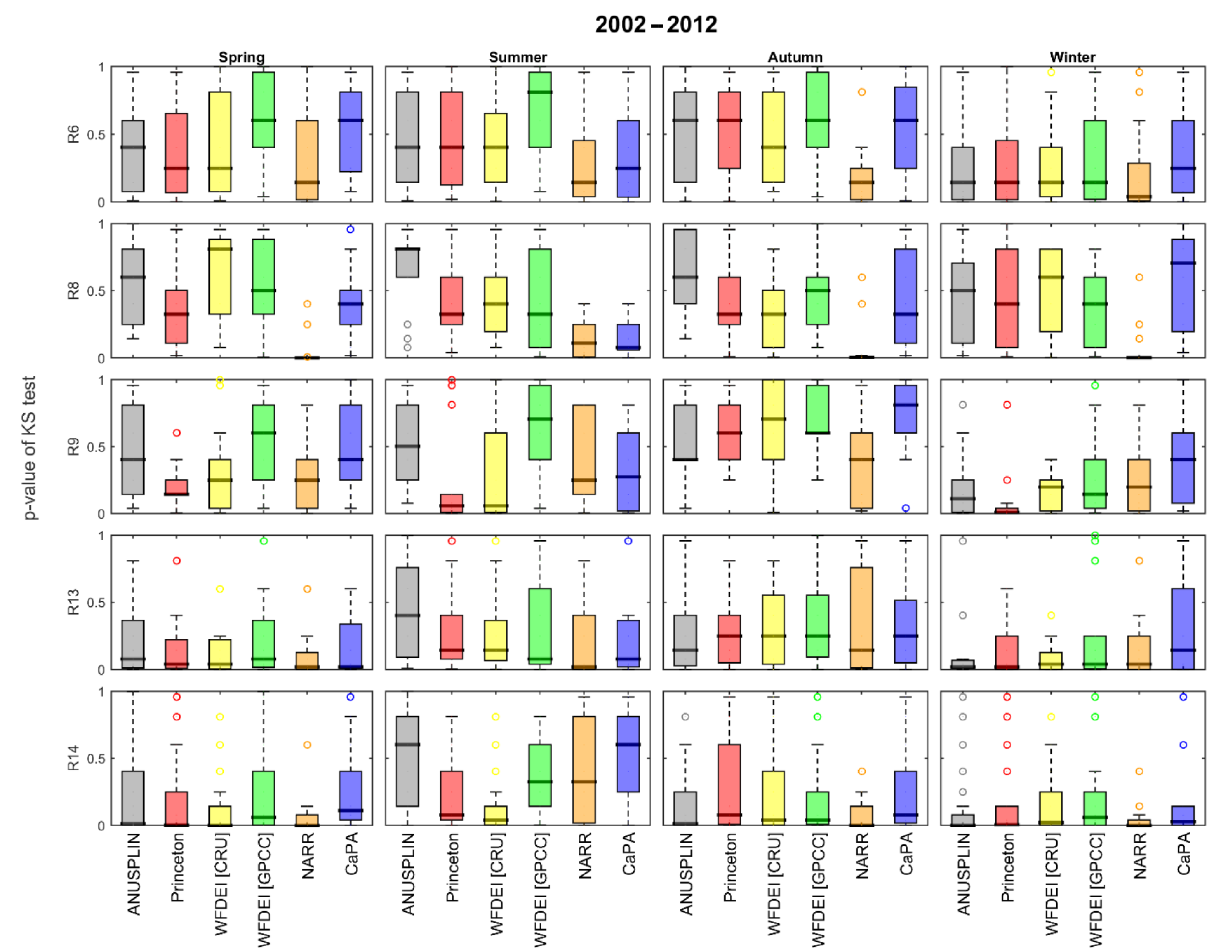
Figure 4. Distributions of p value of the K–S test in four seasons for the period of 2002 to 2012 (short-term comparison with the inclusion of CaPA). Note that the numbers of precipitation-gauge stations in each ecozone are different (see Table 4). The p values of regions 6, 8 to 9, and 13 to 14 (R6, R8–R9, and R13–R14), which are more than or equal to 10 stations, were only shown for illustration in box-and-whisker plots with bottom, band (black thick line), and top of the box indicating the 25th, 50th (median), and 75th percentiles